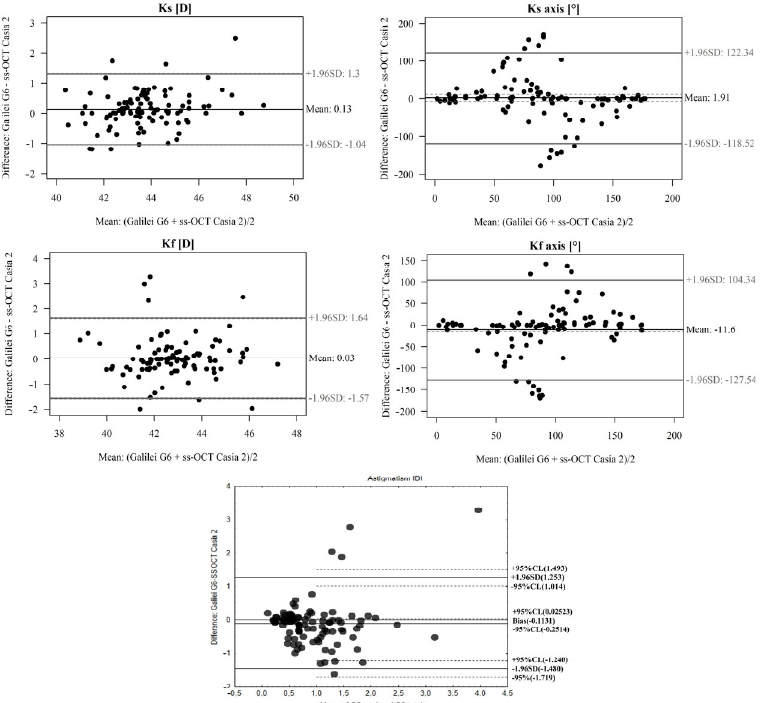
Figure 2. A Bland–Altman plot showing the agreement of total Ks (D), Kf (D), Kf axis ( ◦ ), Ks axis ( ◦ ), and total astigmatism As.(D) measurements between the OCT Casia 2 and GalileiG6 Dual Scheimpflug Analyzer. The line shows the mean difference, and the top and bottom dashed lines show the upper and lower 95% LoA, respectively.